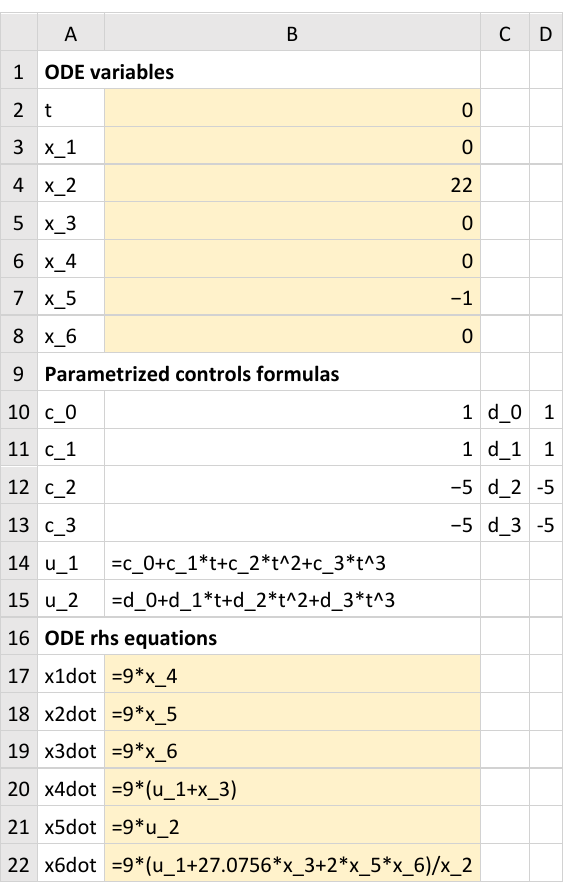
Figure 14. Spreadsheet model for the IVP (18)–(24) with parametrized control functions. The colored ranges are input parameters for IVSOLVE Formula (30).